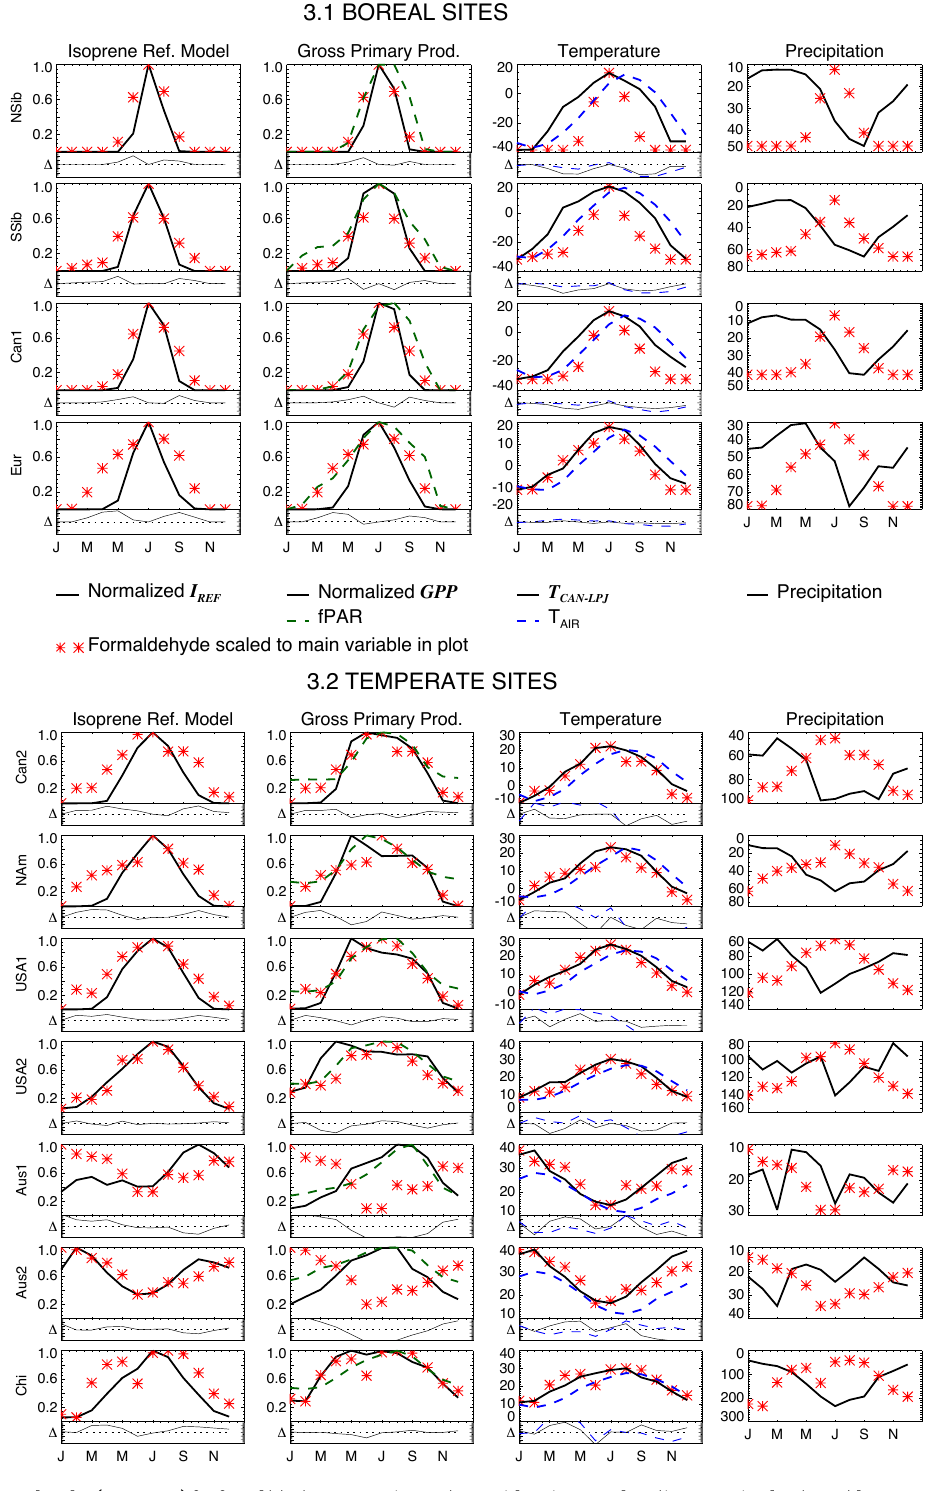
Figure 3. Mean seasonal cycles (1997–2006) for formaldehyde concentrations and potential environmental predictors. Regional and monthly averages are grouped into four panels: boreal regions, temperate regions, tropical forests and tropical savannas. In the first column, the mean seasonal cycle of the reference isoprene model, I REF , is shown as the solid line scaled to the maximum emission in that region; the mean seasonal cycle of the formaldehyde data is scaled to I REF , and plotted as red stars. Below each graph is shown the seasonal pattern of the difference between the formaldehyde data and I REF ( 1 ) to indicate potential seasonal biases. The second column shows the normalized mean seasonal GPP. The formaldehyde seasonal cycle is scaled to GPP and plotted as red stars. The mean seasonal cycle of fPAR is also shown (green dashed line). In the third column, the mean seasonal cycle of modelled canopy temperature ( T CAN - LPJ , degreeC) and the formaldehyde data are shown as the solid line and red stars. The dashed blue line shows the observed air temperature. The panel below shows the difference between the formaldehyde cycle and the modelled canopy temperature as the solid line and formaldehyde minus T AIR as the dashed blue line. The last column shows the mean seasonal cycle of regionally averaged precipitation, with an inverted y